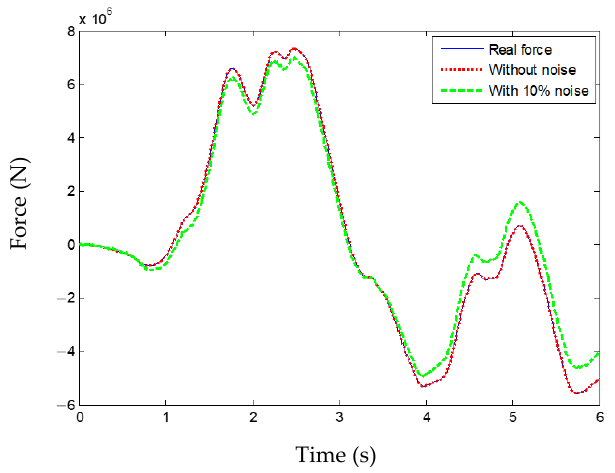
Figure 6. Force identification result (scenarios 1 and 2).